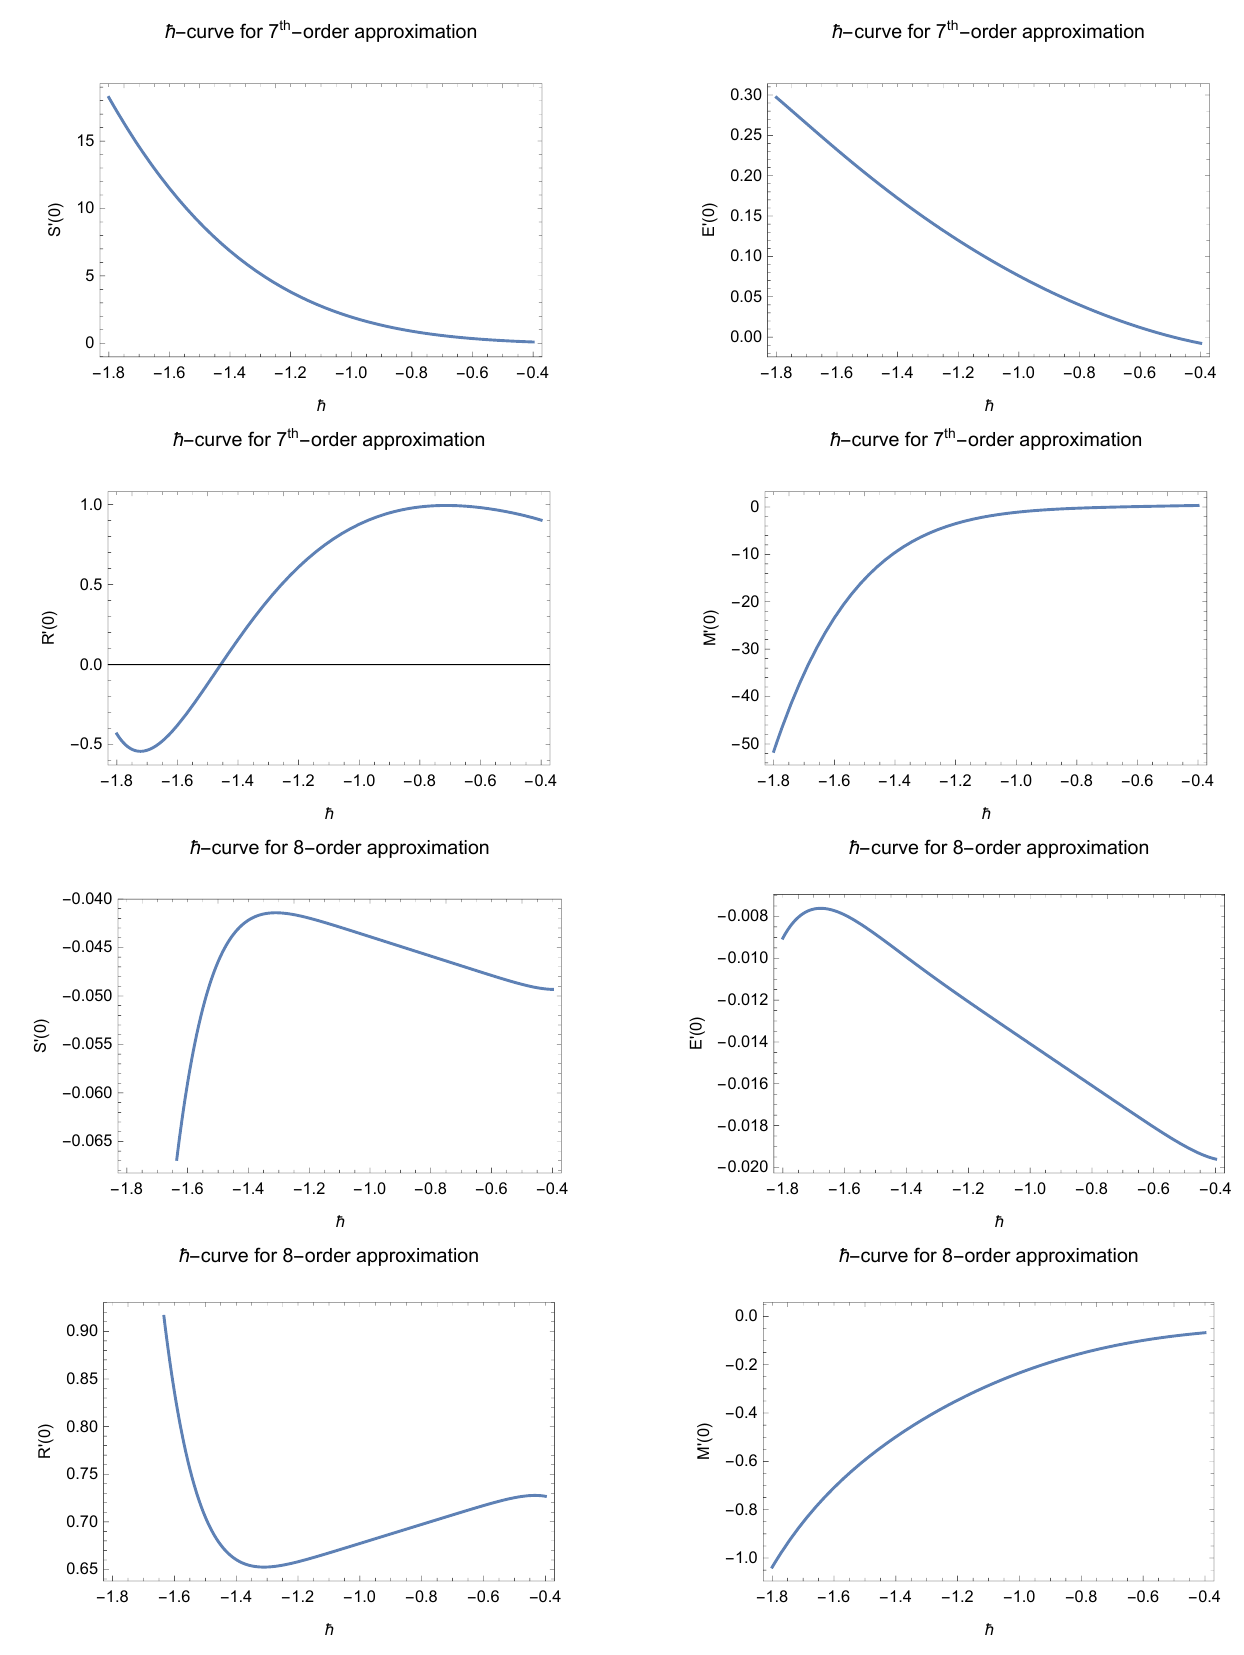
Fig. 4 The h curves initial derivatives of 7 th and 8 th order approximation from HPM Figure 4. The h curves initial derivatives of 7th and 8th order approximation from